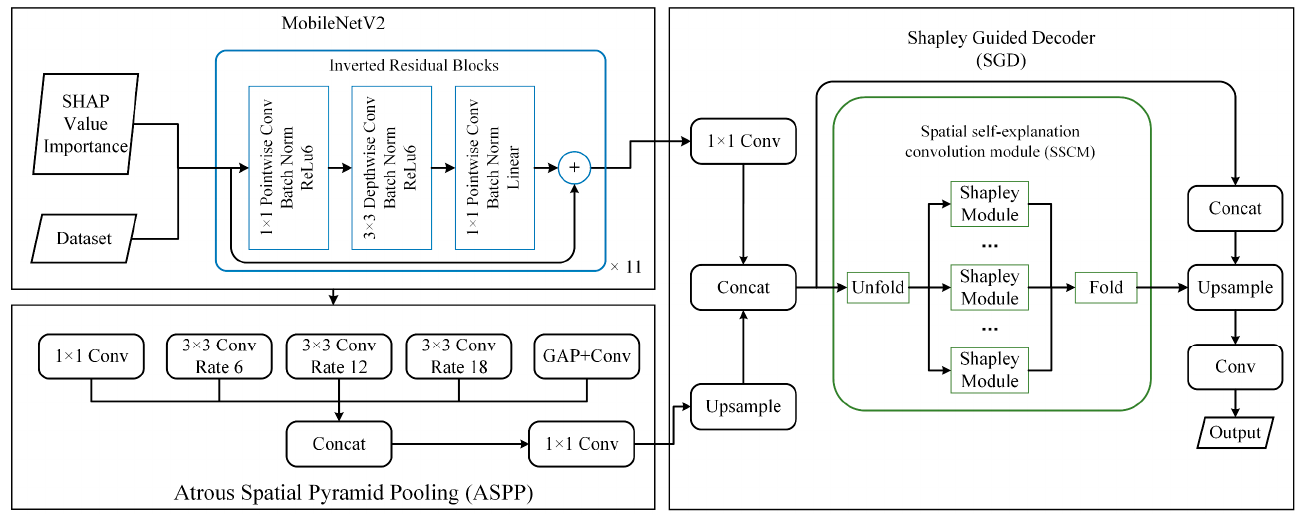
Figure 5. Structure of SHAP ‐ guided spatial explanation network.